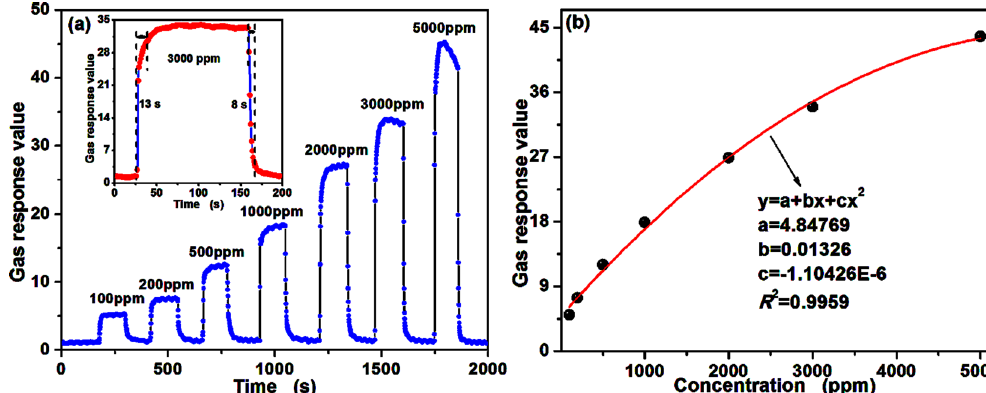
Figure 6. The butane gas-sensing properties of the sensor fabricated from PTO-4 nanoparticles at an operating temperature of 340 °C; ( a ) The dynamic response from 100 to 5000 ppm (the inset is the response/recovery time toward 3000 ppm butane gas), and ( b ) variation of gas response to different butane concentrations from 100 to 5000 ppm.